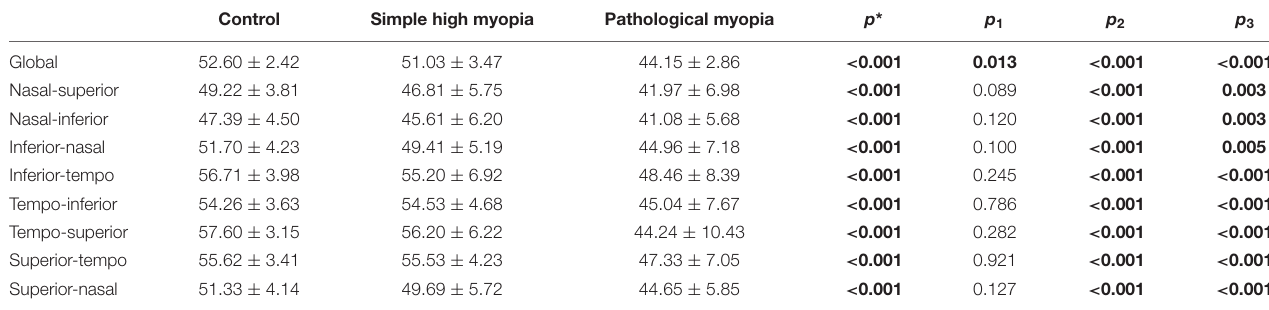
TABLE 2 | The radial peripapillary capillary (RPC) density (%) among the control, simple high myopia, and pathological myopia. Control Simple high myopia Pathological myopia